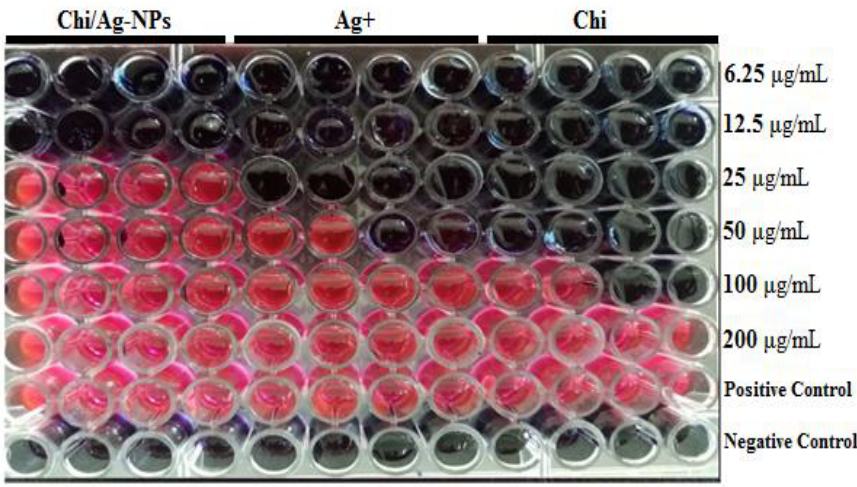
Figure 4. Resazurin dye test for determining minimum inhibitory concentration against S. aureus ATCC ® 25923™ and P. aeruginosa MTCC1034. Table 1. Minimum inhibition concentrations and minimum bactericidal concentrations of Chi, Ag+, and Chi/Ag-NPs samples against gram-negative P. aeruginosa and gram-positive S. aureus . MIC µg/mL Ag+